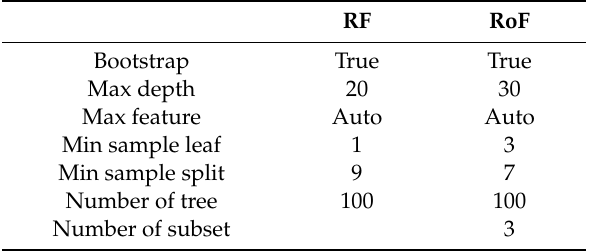
Table 4. Hyper-parameters selected for use in the RF and RoF